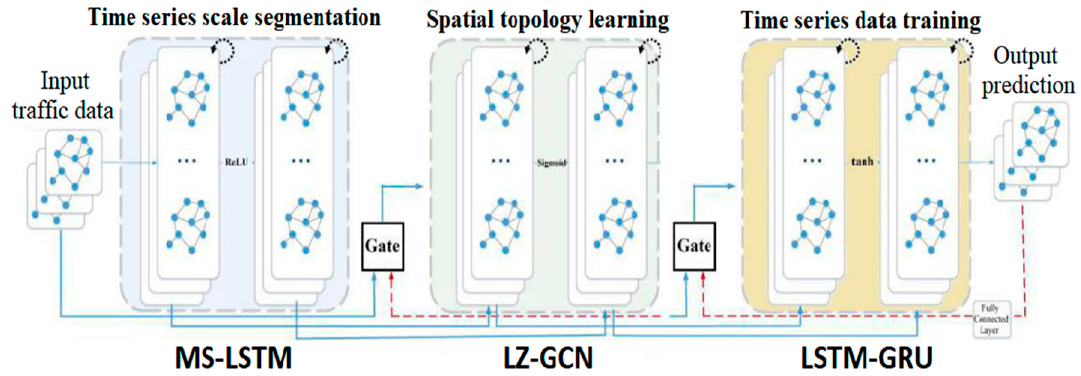
Figure 1. Architecture of